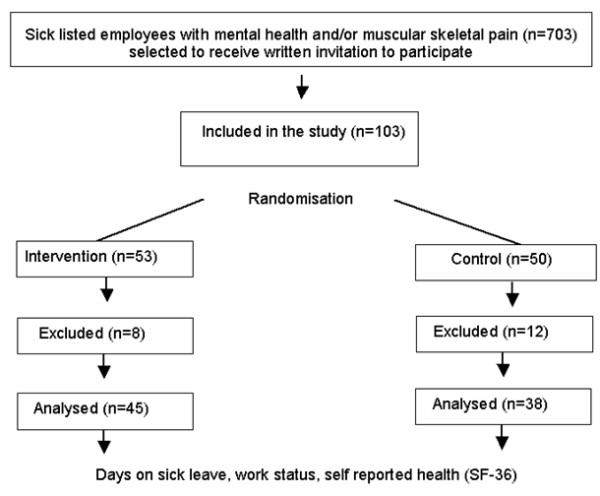
Flowchart of the trial.